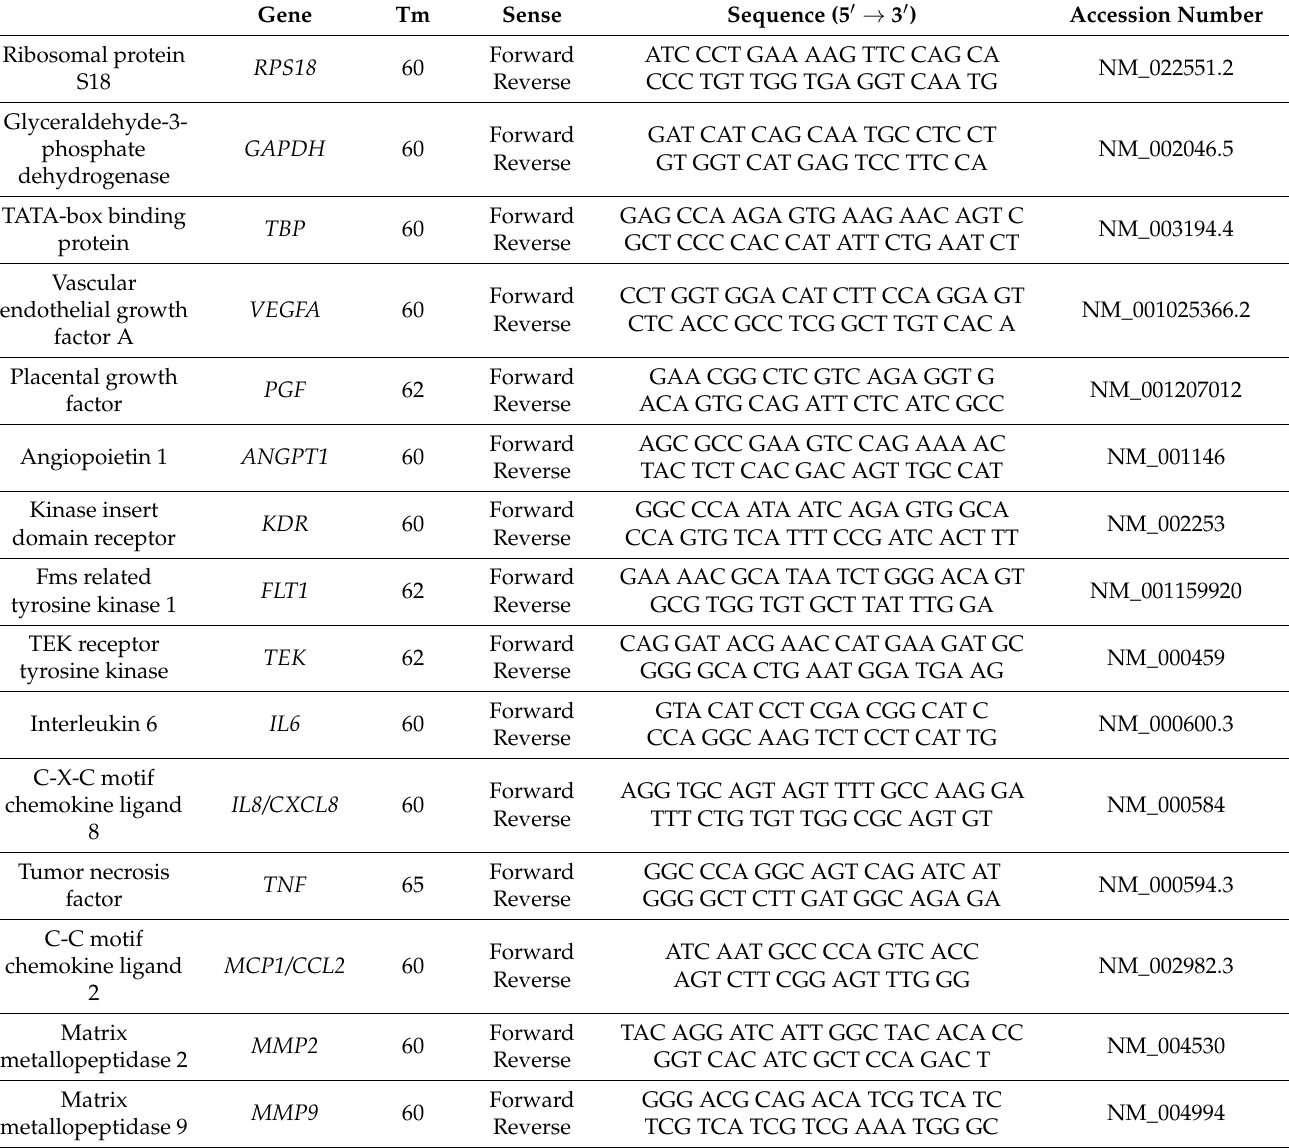
Table 2. Primer sequences used for the Real-Time qPCR